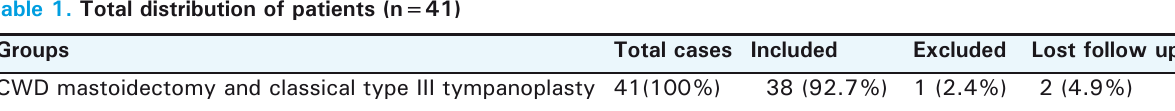
table 2. Age distribution of patients (n=38) Age